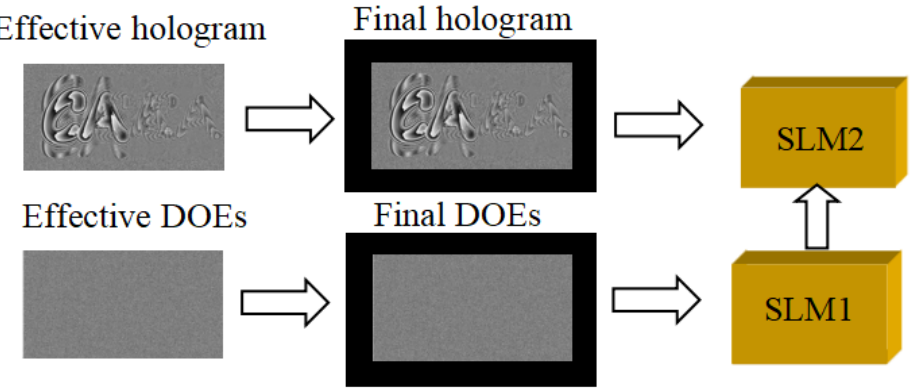
Figure 3. Process of the DOEs loaded on SLM1 and effective hologram loaded on SLM2.